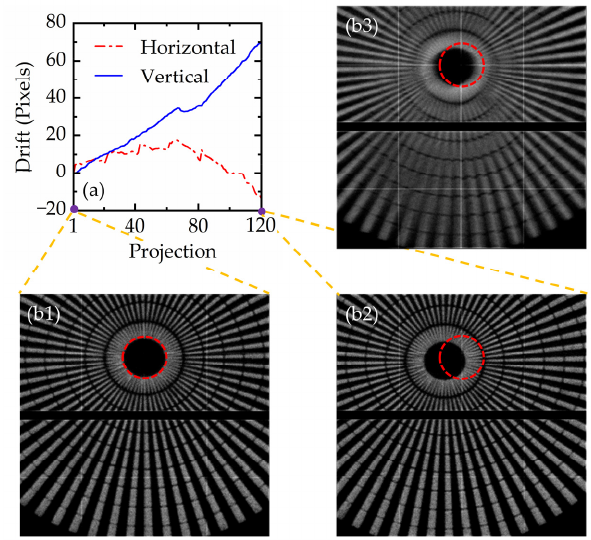
Figure 1. The fixed-angle scanning experiment of a Siemens star. ( a ) Projection drift; ( b1 ) first projection of the star; ( b2 ) last projection of the star (120th); ( b3 ) Mean projection of the star. In addition, the necessity of nano-CT drift correction is also shown through partial derivative analysis. To describe the cone-beam nano-CT system, we introduce the Carte- coordinate system of Figure 2. Under ideal conditions, the object only moves according to the set scanning trajectory, and the object is only rotated by the rotation axis. Under the